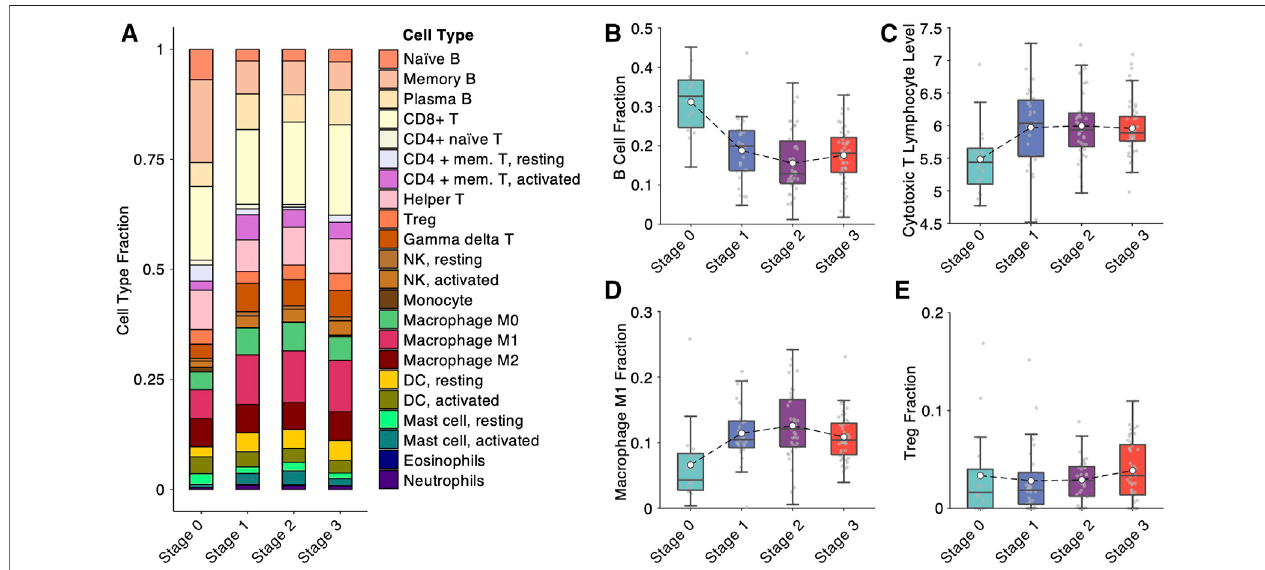
FIGURE 4 | Bulk deconvolution analysis reveals immunological variation during nasopharyngeal carcinoma progression. (A) Cell-type fractions deconvolved from bulkexpressiondatameasuredbymicroarrayfrom113samplesintheintegratedcohort. (B) B-cellfractionfrombulkdeconvolutionatdifferentNPCprogressionstages. (C) CytotoxicTlymphocytelevel,estimatedbyaverageexpressionof CD8A , CD8B , GZMA , GZMB and PRF1 ,atdifferentNPCprogressionstages. (D) M1macrophage fraction from bulk deconvolution at different NPC progression stages. (E) Treg (regulatory T) cell fraction from bulk deconvolution at different NPC progression